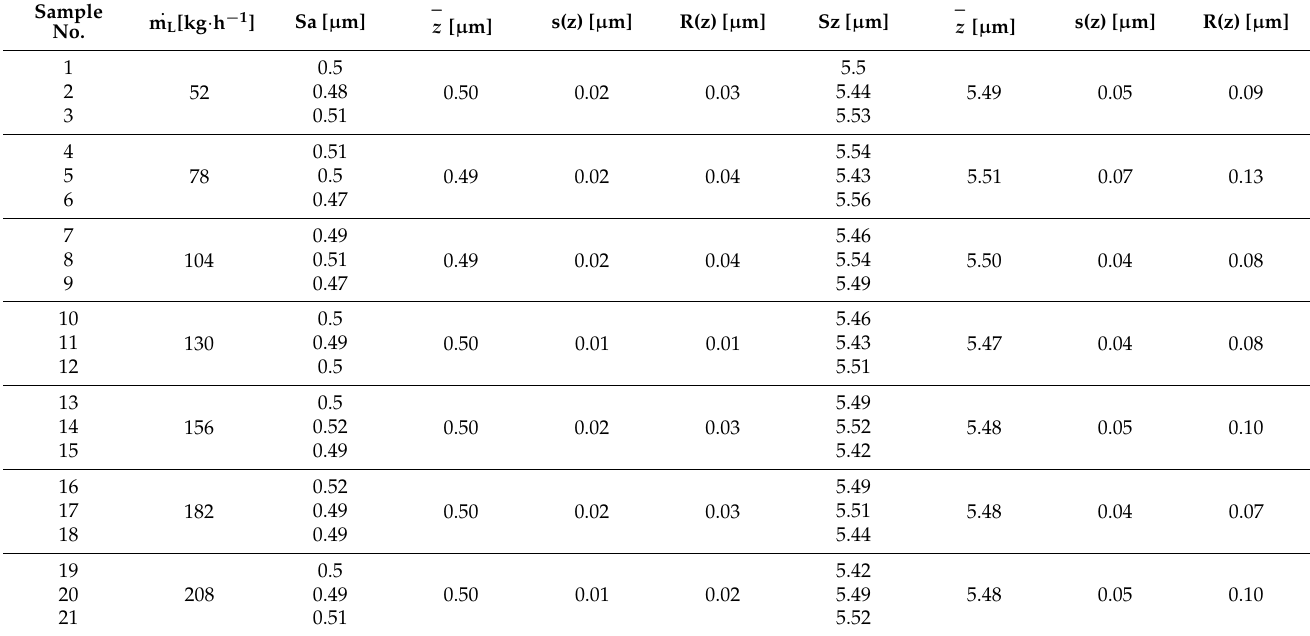
Table 11. Sa and Sz measurement results of polymethyl methacrylate PMMA samples after paint removal (p w = 20 MPa, l 2 = 250 mm, κ = 90 ◦ ).